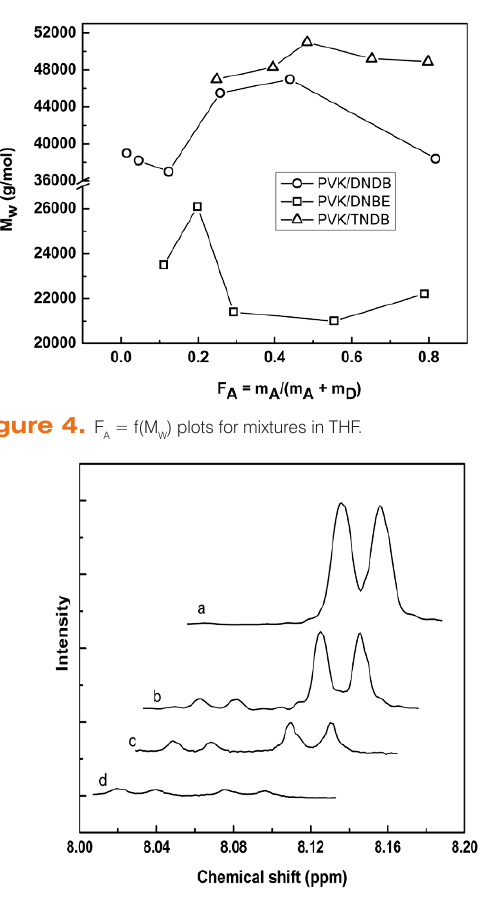
Figure 5. Expanded 1 H-NMR spectra for DNDB in mixtures with different PVK concentrations : (a) 0 M, (b) 0.114 M, (c) 0.331 M, and (d) 0.927